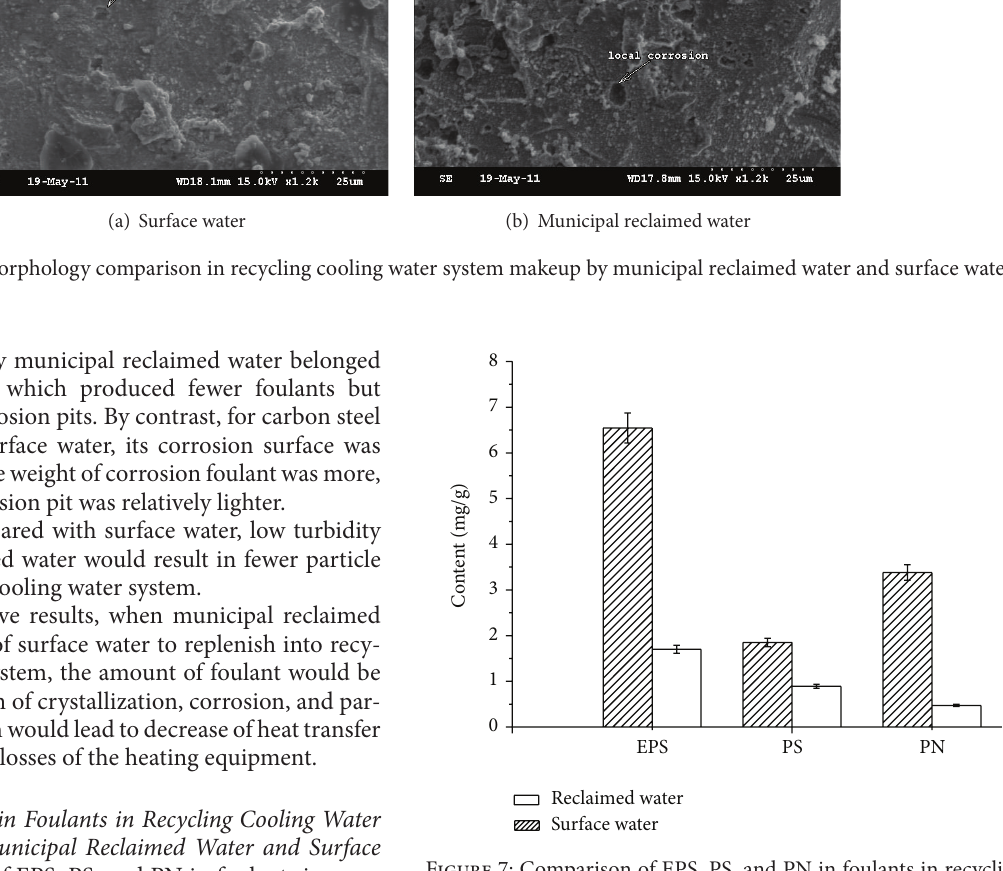
Figure 7: Comparison of EPS, PS, and PN in foulants in recycling cooling water system makeup by municipal reclaimed water and surface